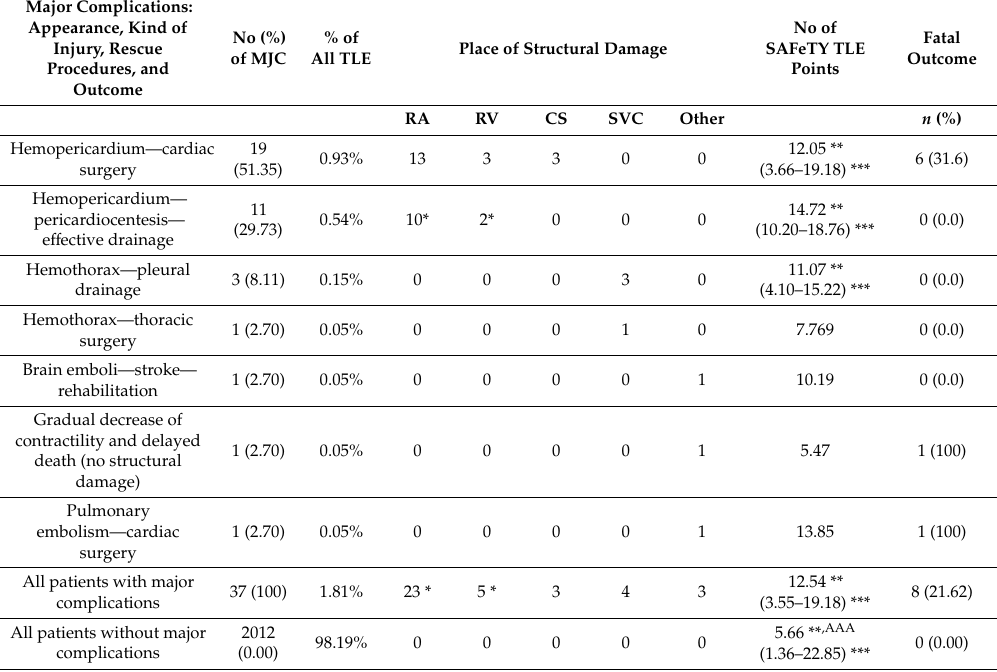
Table 4. List of major complications with an assessment of the number of SAFeTY TLE points in the study population.